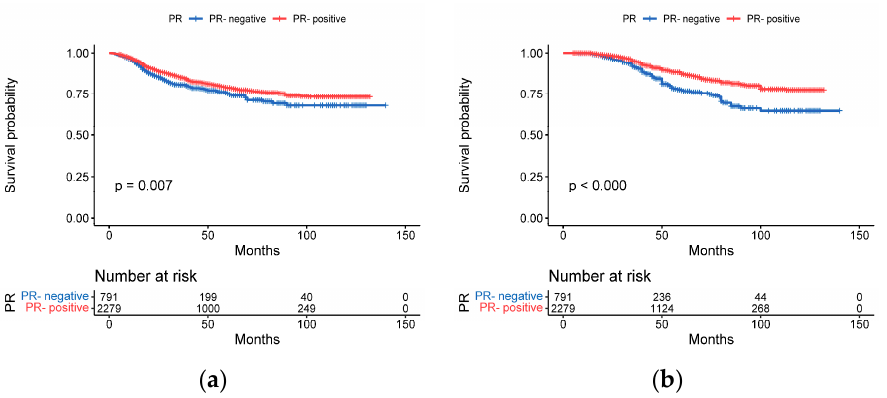
Figure 3. Kaplan ‒ Meier curves for DFS and OS by PR status. ( a ) DFS for PR negativity vs. PR posi- Figure 3. Kaplan–Meier curves for DFS and OS by PR status. ( a ) DFS for PR negativity vs. PR tivity ( b ) OS for PR negativity vs. PR positivity. positivity ( b ) OS for PR negativity vs. PR positivity.